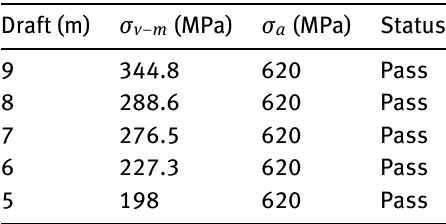
Figure 14: Comparison of strain contour plots at different draft Table 9: Comparison of the stress test results and status of the draft